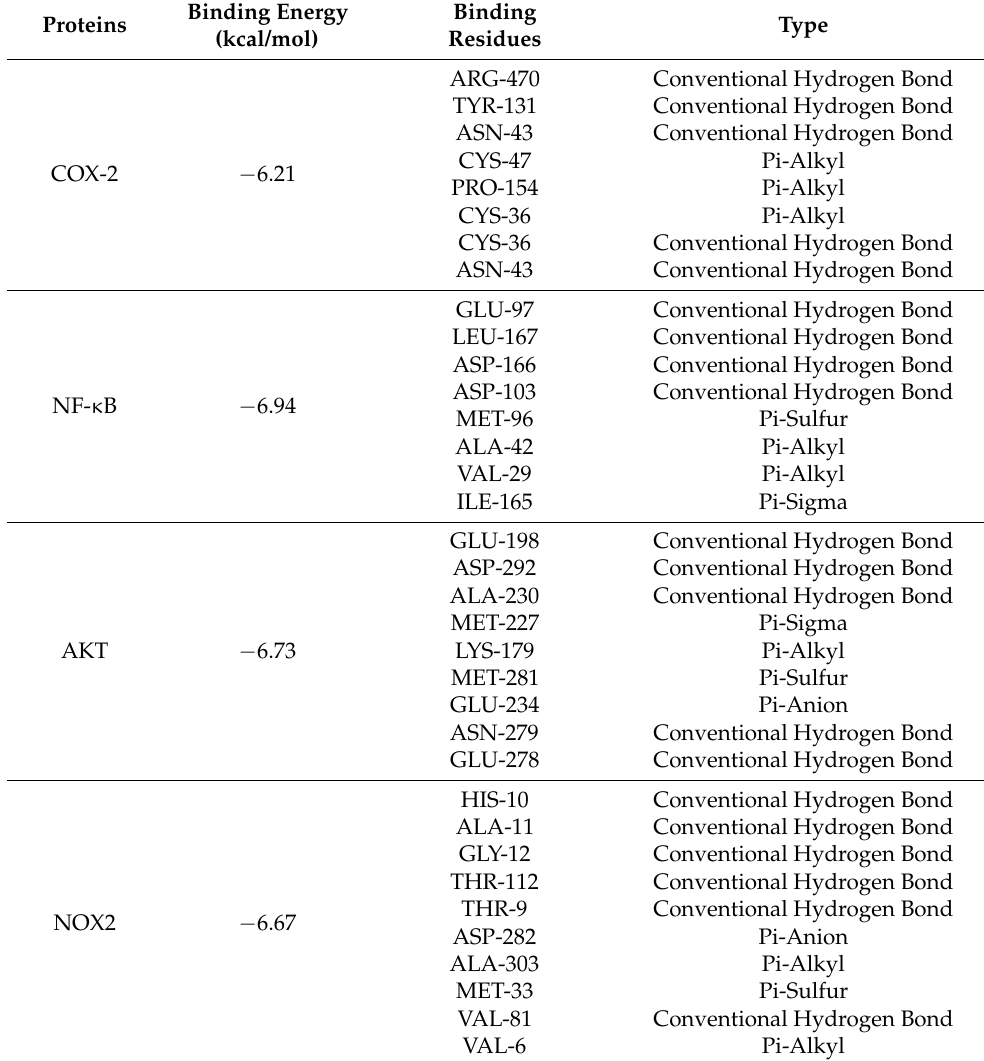
Table 6. Intermolecular interactions between rosmarinic acid and COX-2, NF- κ B, AKT, and NOX2.